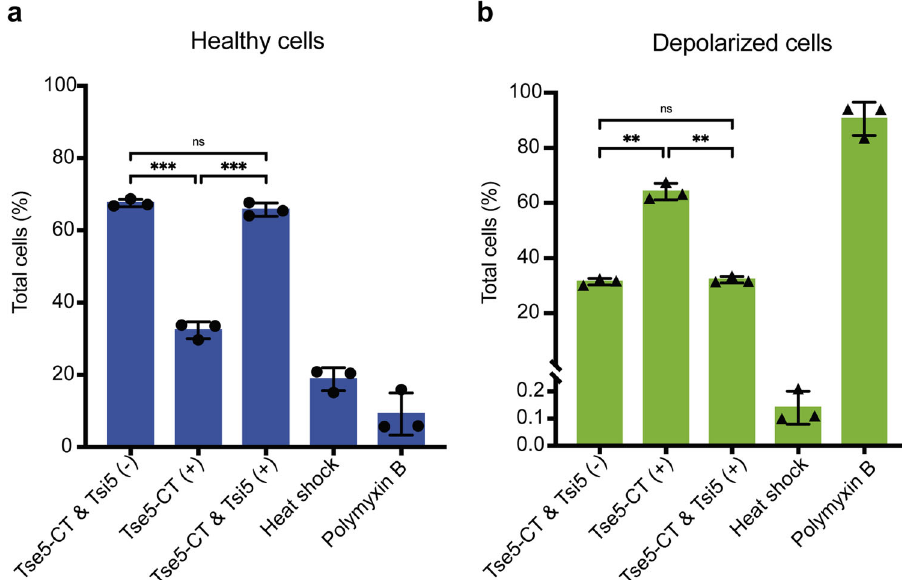
Fig. 3 Tsi5 can protect from Tse5-induced membrane depolarisation. Flow cytometry experiments were performed with P. putida cells harbouring plasmids directing the expression of Tse5-CT (Tse5-CT + ) or Tse5-CT and Tsi5 (Tse5-CT + and Tsi5 + ). As a negative control, the graphs include the fl ow cytometry results of cells transformed with pS238D1:: tse5-CT and pSEVA424:: tsi5 plasmids and without inducing the expression of the proteins (Tse5-CT − and Tsi5 − ). Each graph includes two positive controls: cells treated with a heat shock that results in cell permeabilization and cells treated with polymyxin B, which results in cell depolarisation. a Flow cytometry results showing healthy cell populations. Healthy cells are not marked with any fl uorophore. b Flow cytometry data show depolarised cell populations. Depolarised cells stain with DiBAC 4 (3). All measurements were made in triplicate ( n = 3 biological replicates). The graphs show the mean values and ± standard deviations (SD). The one-way ANOVA (Brown – Forsythe ANOVA test) with Dunnett´s T3 multiple comparisons test was used to determine whether there is a signi fi cant difference between the mean values of our independent groups (non- signi fi cant [ns] if p > 0,05, * if p ≤ 0.05, ** if p ≤ 0.01, *** if p ≤